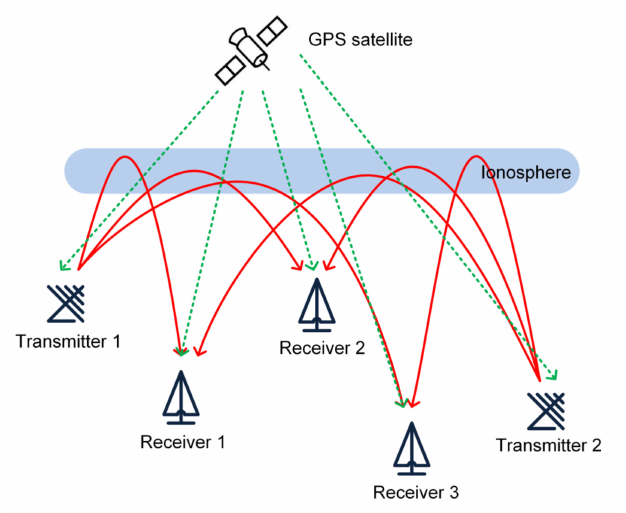
Figure 1. Simplified diagram of the working principle of an oblique-incidence ionosonde detection network composed of two transmitters and three receivers. The global positioning system (GPS) satellite provides time and frequency synchronization signals to all the transmitters and receivers.